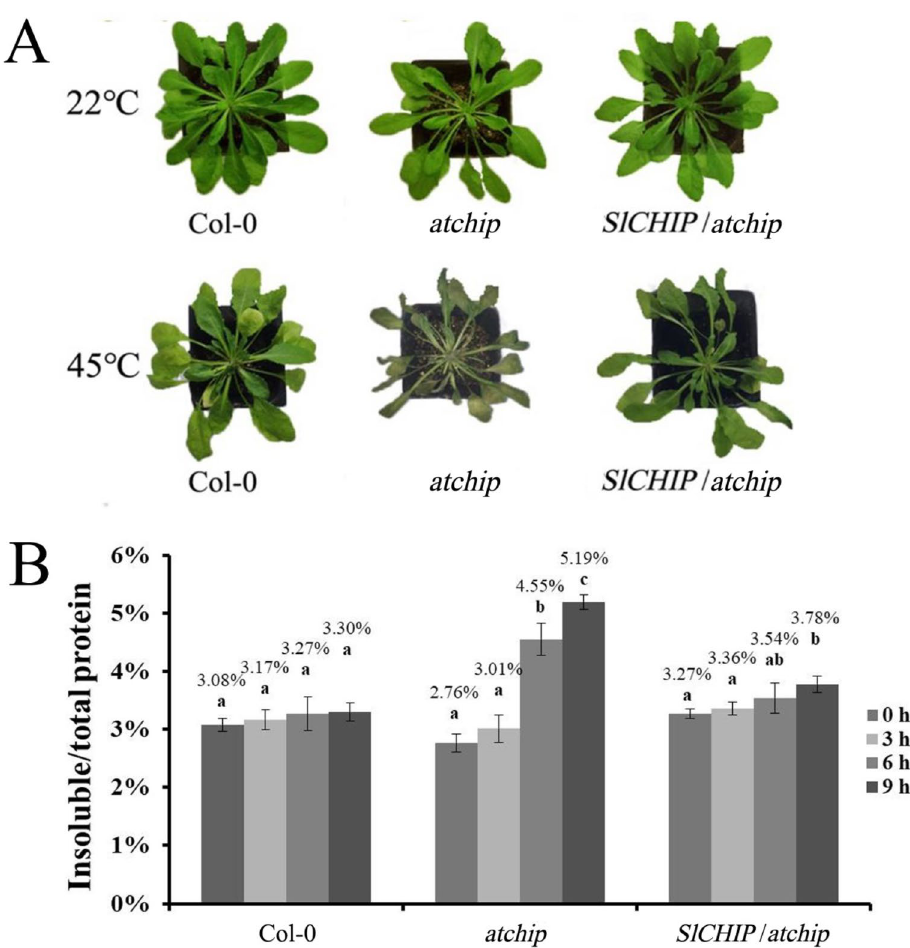
Figure 8. SlCHIP rescued the heat sensitive phenotype of Arabidopsis atchip mutant. ( A ) Phenotypic analysis of Arabidopsis wild type Col-0, Arabidopsis atchip mutant and transgenic SlCHIP / atchip plants after 9 h heat stress. Plants were kept in 45 °C. Pictures were taken before and after 9-h heat treatment. ( B ) Accumulation of insoluble protein aggregates. Leaf tissues from Col-0, atchip and transgenic SlCHIP / atchip plants were collected at indicated hours at 45 °C for extraction of total, soluble and insoluble proteins as described in Materials and Methods. The starting homogenates as total proteins and the last pellets as insoluble proteins were used to calculate the percentages of insoluble proteins to total proteins. Error bars indicate SE (n = 6). According to Tukey’s multiple comparisons test ( P = 0.01), means do not differ significantly if they are indicated with the same letter. The experiments were repeated for three times with similar